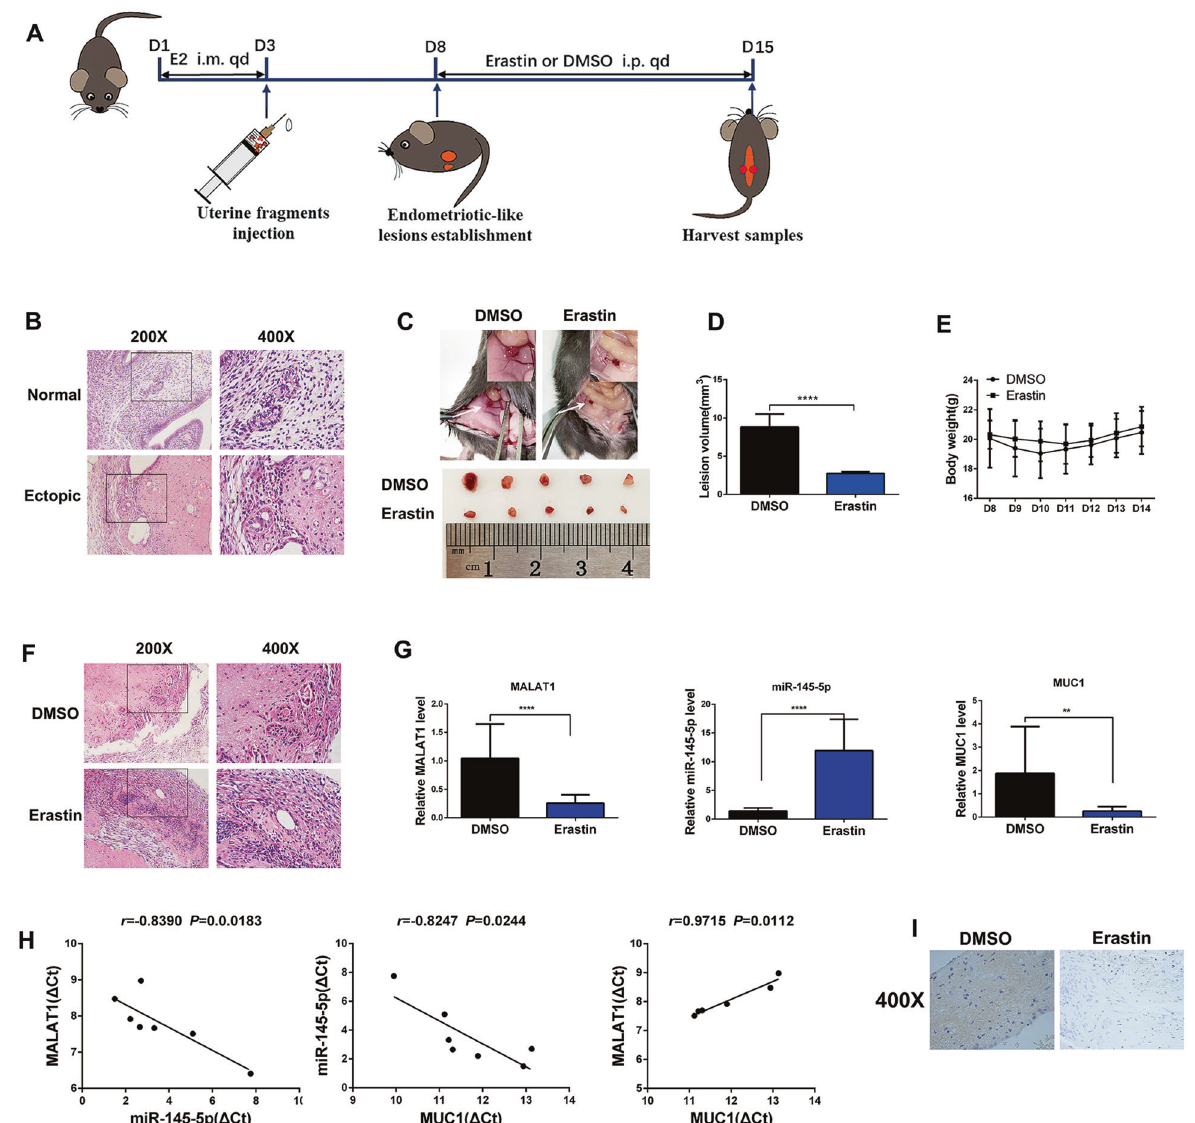
Fig. 7 Erastin-induced ferroptosis shrinks endometriotic lesions by regulating the MALAT1/miR-145-5p/MUC1 axis in vivo. A Flowchart for the establishment of the mouse endometriosis therapeutic model. B The successful establishment of the endometriosis model was veri fi ed by H&E staining of ectopic lesions. The scale bar = 100 µm for ×200, 50 µm for ×400. C Representative visible lesions in the peritoneal cavity of a mouse model of endometriosis after treatment with erastin (20 mg/kg) or DMSO for 7 days are shown. D The volume of ectopic lesions was reduced after treatment with 20 mg/kg erastin for 7 days. E Body weights of the DMSO group and erastin group measured every day. Body weight did not change signi fi cantly after erastin treatment compared with the control group. F H&E staining showed that the glandular and stromal structures of ectopic lesions completely disappeared after erastin treatment. G The mRNA expression of MALAT1, miR-145-5p, and MUC1 in the DMSO group and erastin group was analyzed by qRT-PCR. H Correlations between the expression of MALAT1 and miR-145-5p, miR-145-5p and MUC1, MALAT1 and MUC1 in the erastin group were analyzed using the Pearson ’ s test. I The protein expression of MUC1 was detected by immunohistochemical staining. The scale bar = 50 µm for ×400. All data are shown as the mean ± SD of three independent experiments (** P < 0.01, **** P < 0.0001, Student ’ s t test). MALAT1 metastasis-associated lung adenocarcinoma transcript 1, MUC1 mucin 1, i.p. intraperitoneal injection, i.m. muscle injection, E2 17- β -estradiol-3-benzoate, qod every other day, qd once a